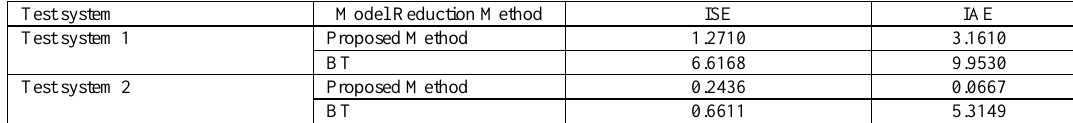
Table 2. Performance analysis of proposed with other existing reduction methods for test